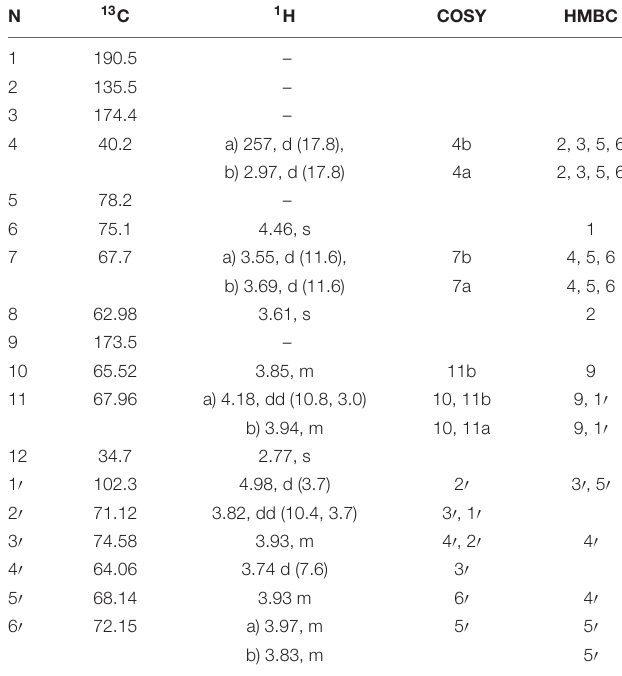
was reflected in long-range correlations visible in the HMBC spectrum (H-11a at δ H 4.18 and H 11b at δ H 3.94 to C-1 (cid:48) at δ C 102.3), and relevant bonds between atoms are indicated by arrows in Figure 2 . As no long-range correlations could be found to determine the exact location of the side chain, its